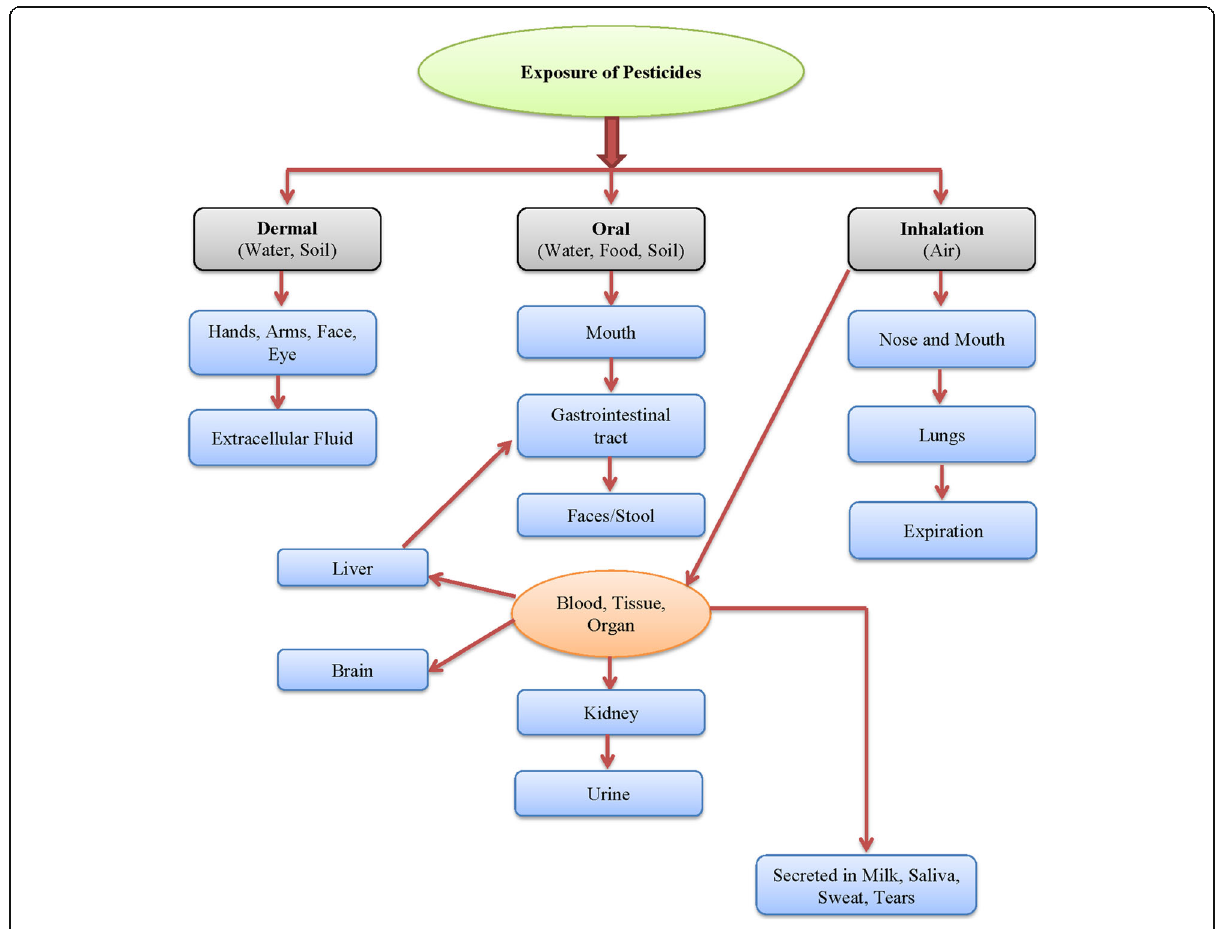
Fig. 2 Route of pesticide exposure in human